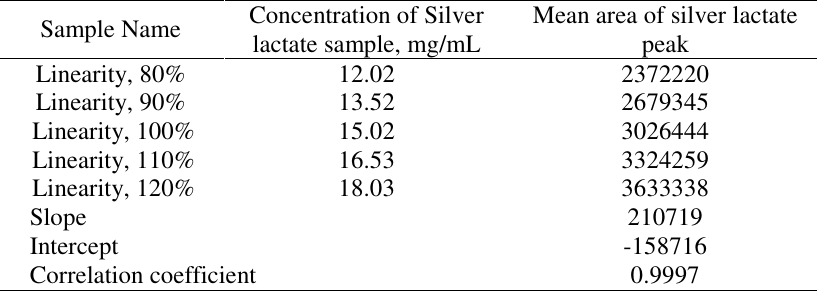
Table 3 . Linearity of lactic acid peak in silver lactate sample